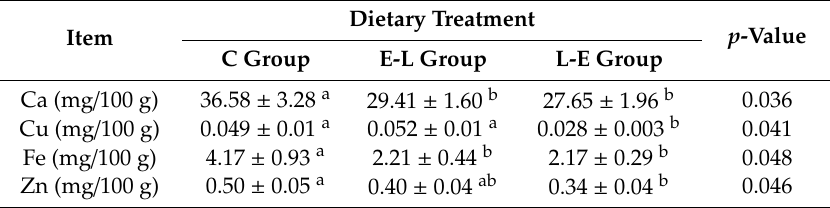
Table 7. The concentrations of Ca, Cu, Fe, and Zn in the serum of sows and umbilical cord at parturition ( n = 9). Dietary Treatment Item C Group